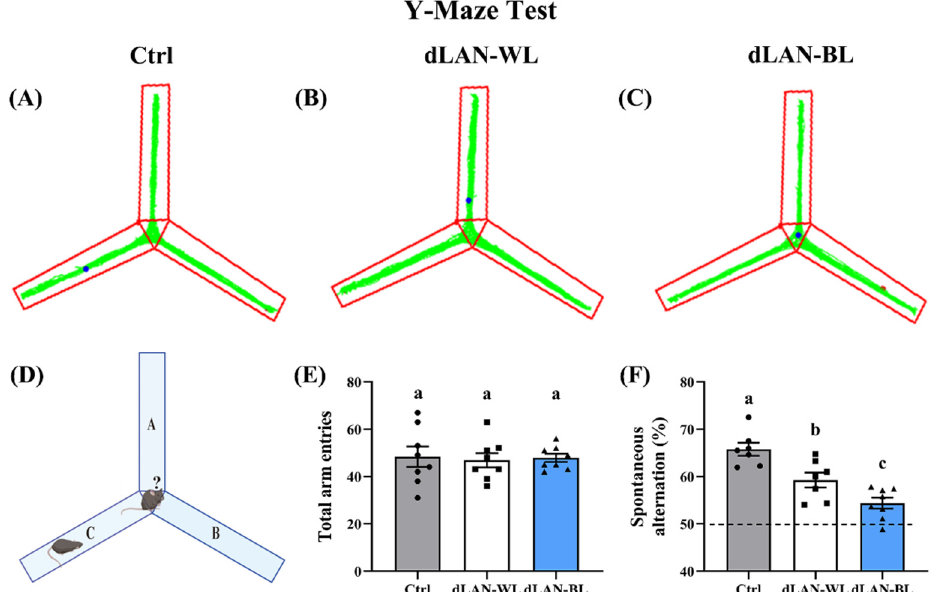
Figure 1. Effect of dim light at night on the ability of spatial learning and memory in mice. ( A – C ) Track plot of Y-maze test. ( D ) Schematic diagram of the Y-maze. ( E ) Number of arm entries in the Y-maze test in each group. ( F ) Alternation behavior in the Y-maze test in each group. The data are expressed as the mean ± SEM; n = 8 for each group. Values not sharing a common superscript letter (a,b,c) differ significantly at p < 0.05; those with the same letter (a,b,c) do not differ significantly ( p ≥ 0.05). Ctrl: control group, dLAN-WL: dim white light at night group, dLAN-BL: dim blue light at night group.